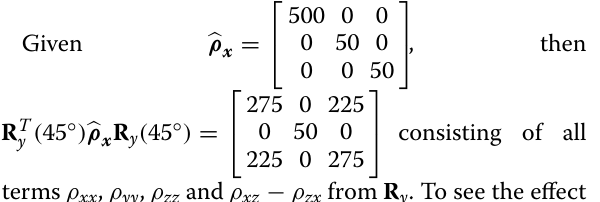
Fig. 8 a The surface logarithmic plot of Z inf xy ( s ) , Z inf yx ( s ) , Z inf xx ( s ) , and Z inf yy ( s ) , and T edge x ( s ) , and T edge y ( s ) at all 484 stations from top to bottom rows, respectively, obtained when the 3‑D anisotropic body in Fig. 1 (shown as a dashed line) is assigned with R T y ( 45 ◦ ) surface (0 km), and at a depth of 5 km, given R T ◦ ) ρ x R y ( 45 ◦ ) , y ( 45 (cid:31)